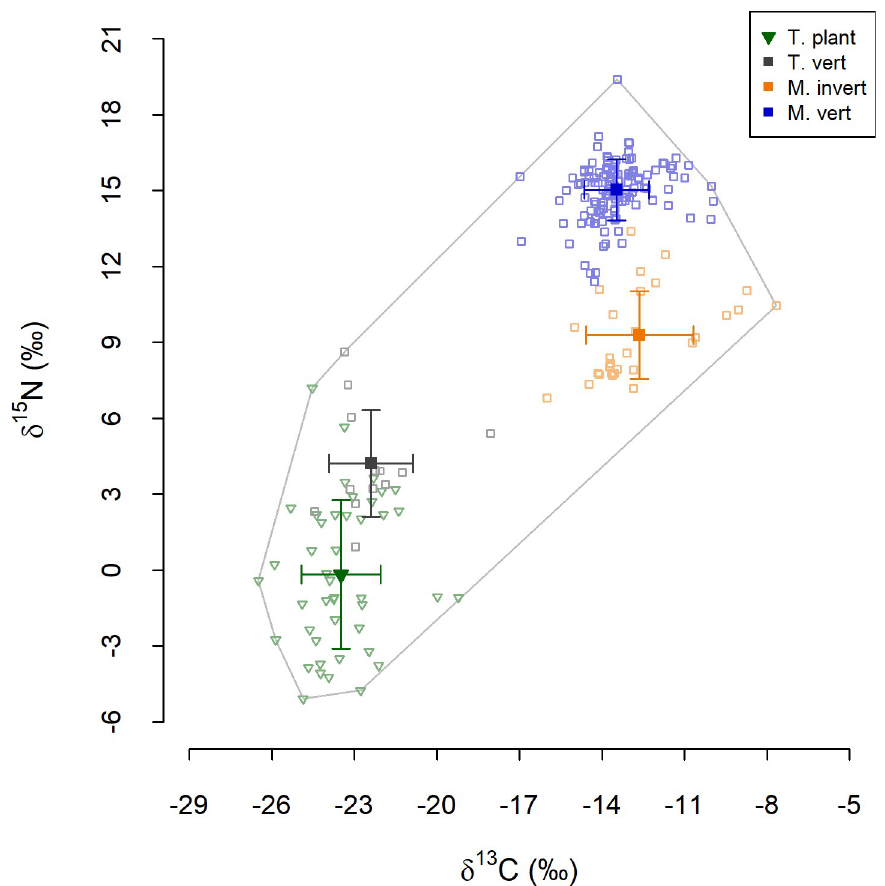
Fig 2. Isotope ratios of sources in models of Cape Peninsula Later Stone Age human diet. Open symbols denote raw values for individual plants and animals as indicated in the key. The grey outline indicates the minimum convex polygon around all raw values. Filled symbols and error bars show mean values and standard deviations for each group.